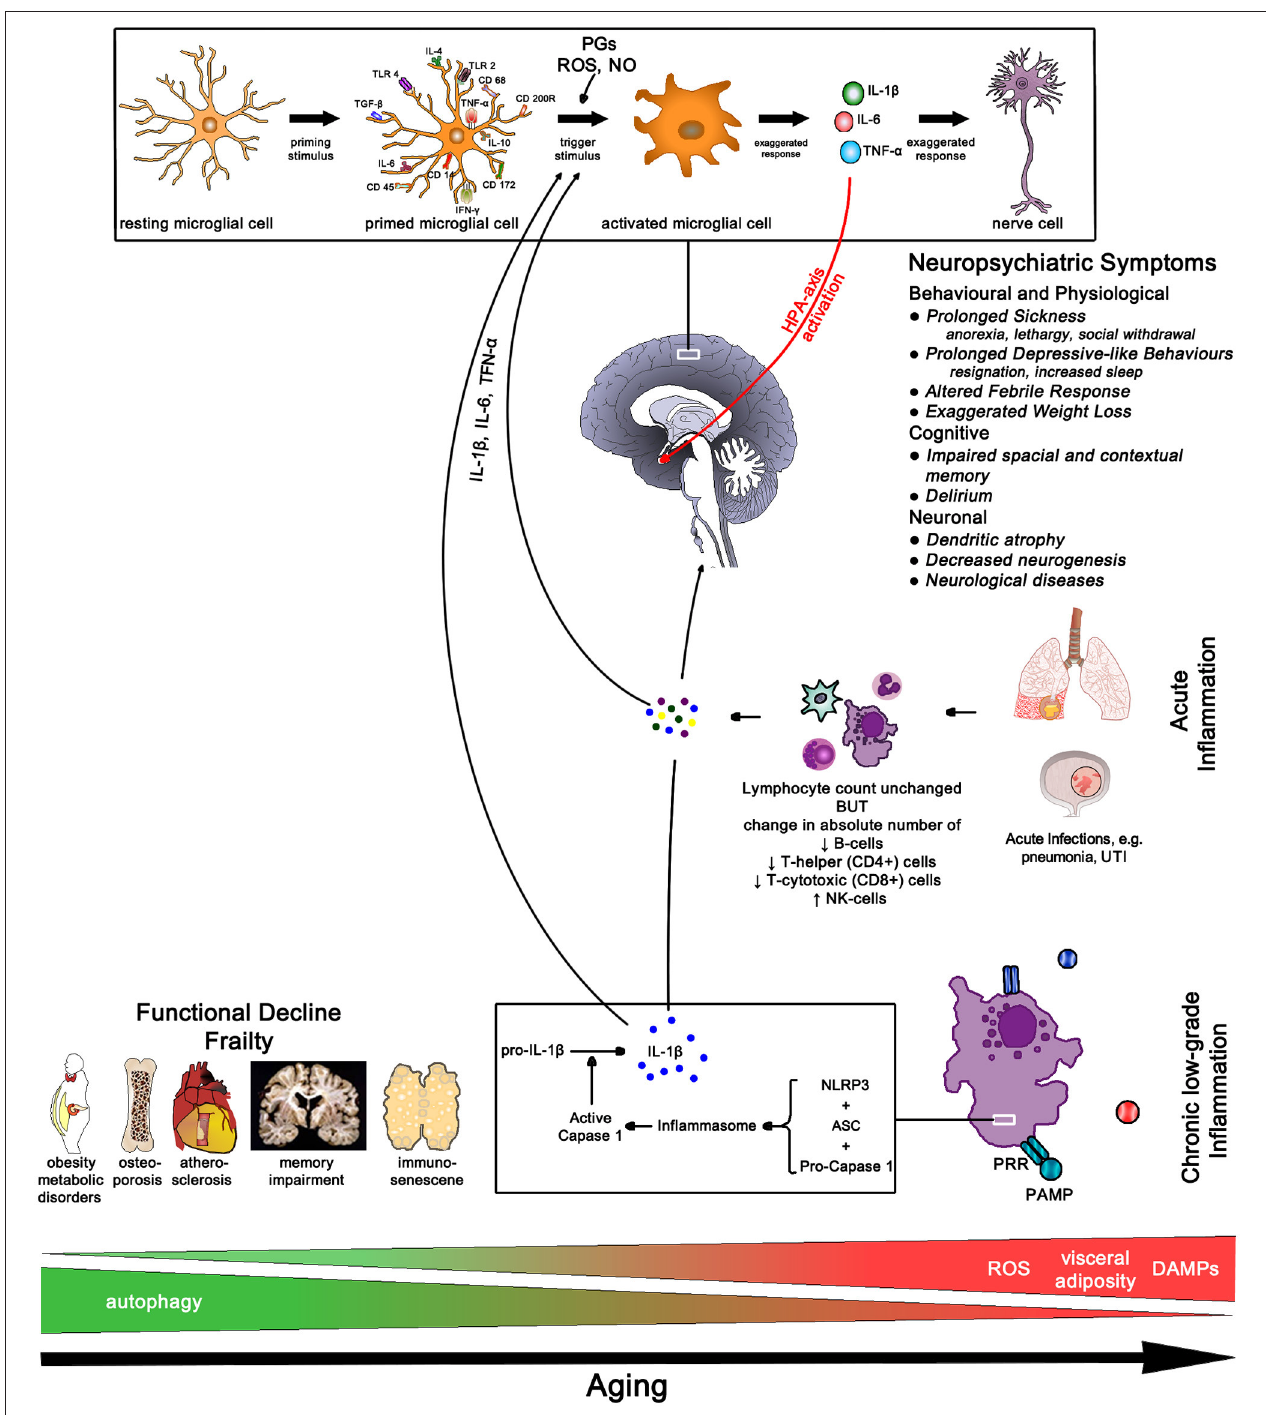
FIGURE 12 | Aging Pathways—chronic low-grade inflammation results in functional decline and frailty. In older age the sudden rise in cytokine load due to an acute infection often results in neuropsychiatric conditions with slow and often incomplete recovery. IL-1 β , interleukin-1 beta; IL-4, interleukin-4; IL-6, interleukin-6; IL-10, interleukin-10; TLR, toll-like receptor; TGF- β , transforming growth factor beta; TNF- α , tumor necrosis factor alpha; IFN- γ , interferon gamma; PGs, prostaglandins; ROS, radical oxygen species; NO, nitric oxide; NLRP3, nucleotide-binding domain leucine-rich repeat protein 3; ASC, apoptosis-associated speck-like protein containing a CARD; PRR, pattern recognition receptor; PAMP, pathogen-associated molecular pattern; DAMPs, damage-associated molecular patterns; UTI, urinary tract infection.